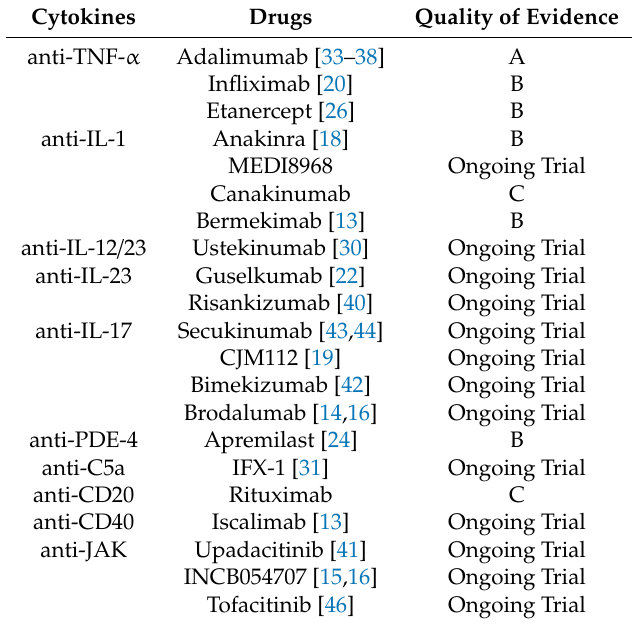
Table 3. Recruiting interventional studies on target therapies.